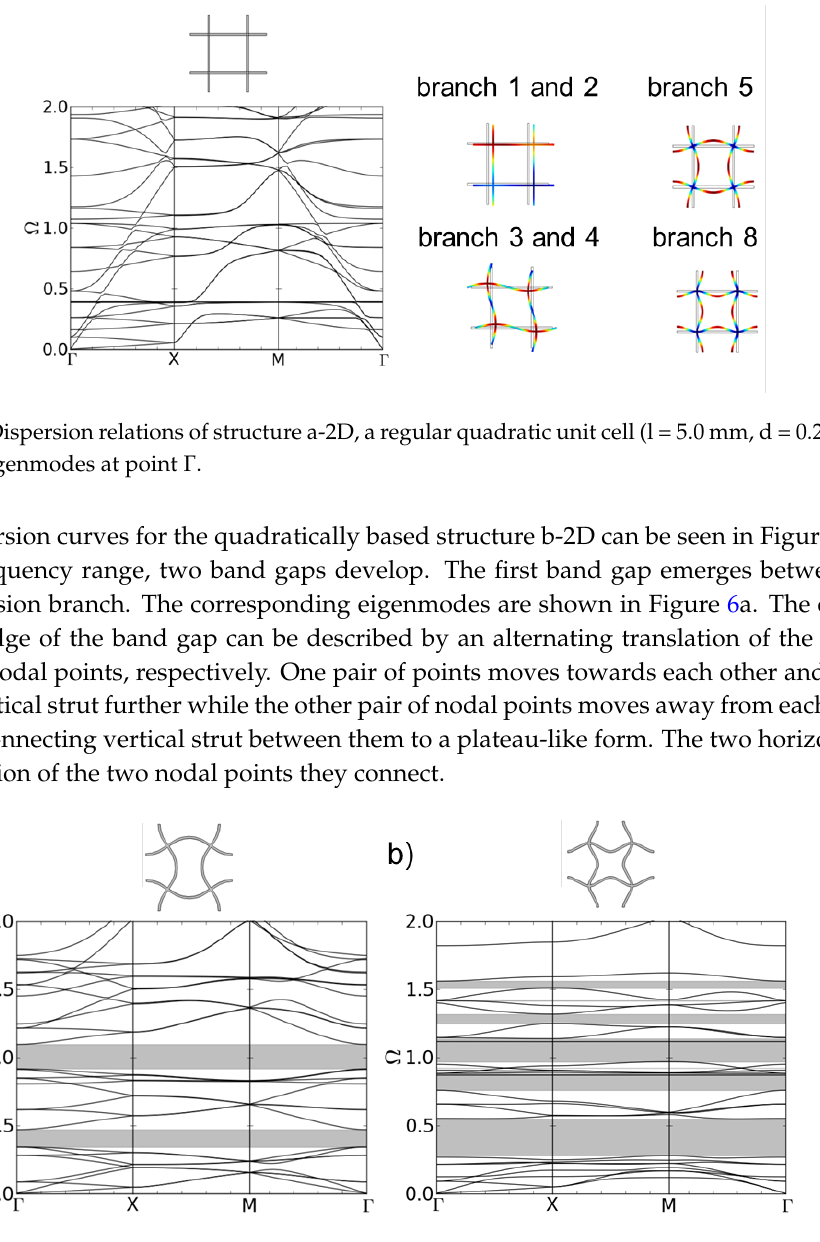
Figure 5. Dispersion relations of structure b-2D, the eigenmode with chiral nodal points ( a ); and structure c-2D, the eigenmode with fixed nodal points (l = 5.0 mm, A = 1.0 mm, d = 0.25 mm) ( b ).